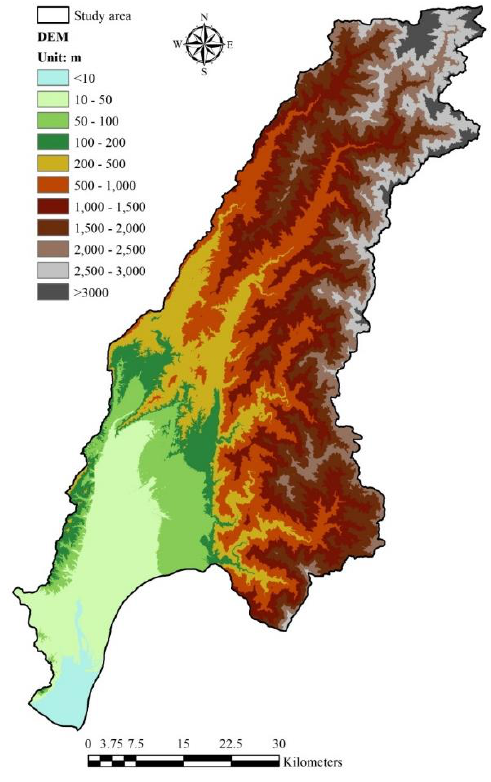
Figure 5. Digital elevation model (DEM) of the Gaoping River watershed.